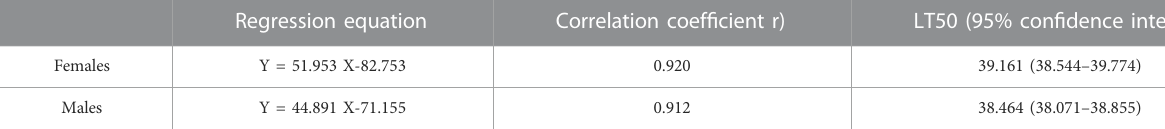
TABLE 2 The LT 50 values of Z. tau adults after 12 h of exposure to different high-temperature treatments.